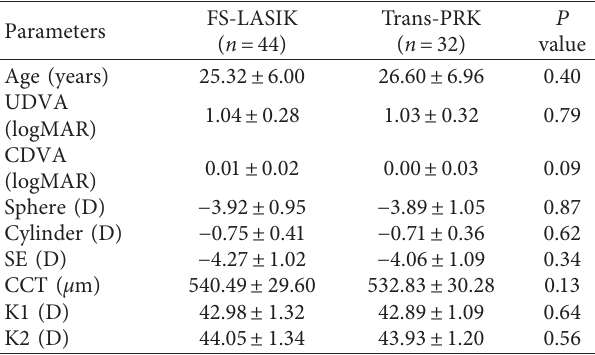
FS-LASIK: femtosecond laser-assisted in situ keratomileusis; Trans-PRK: transepithelial photorefractive keratectomy; CDVA: corrected distance visual acuity (with spectacles); UDVA: uncorrected distance visual acuity; SE: spherical equivalent; D: diopters, CCT: central corneal thickness; K1: cornea flat meridian curvature; K2: cornea steep meridian